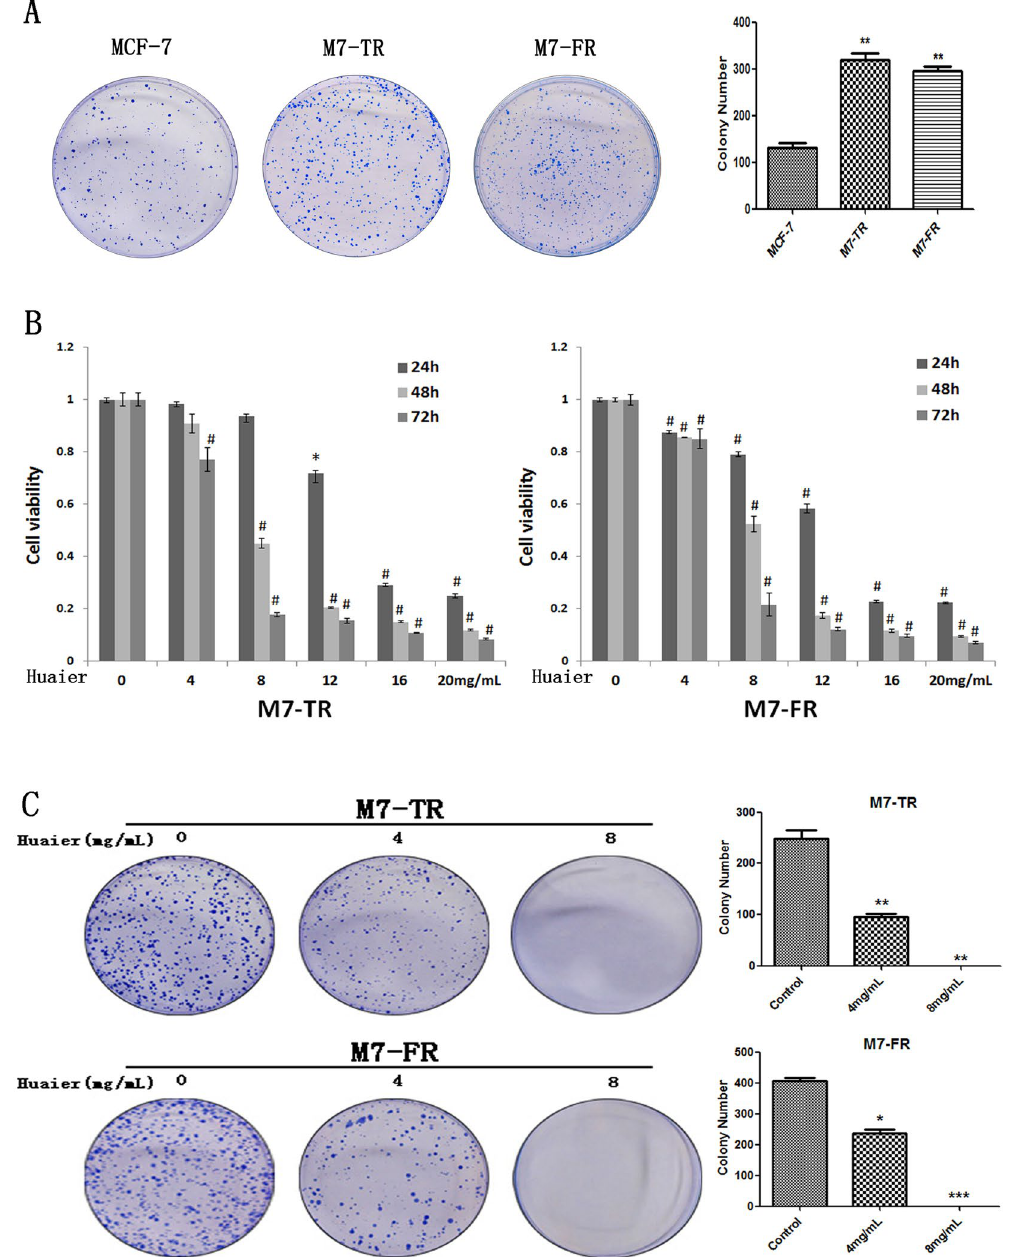
Figure 1. The effects of the indicated concentrations of Huaier extract on cell viability and clone formation capacity in M7-TR and M7-FR cells. ( A ) Cell proliferation of endocrine-resistant breast cancer cells (M7- TR and M7-FR) and endocrine-sensitive breast cancer cells (MCF-7). ( B ) The effects of Huaier extract on cell viability were measured by MTT assay. Huaier extract inhibited cell viability in both cell lines. ( C ) Representative images and the colony formation rates of M7-TR and M7-FR cell colonies after treatment with Huaier extract for 24 h. * P < 0.05 or # P < 0.01, compared with the controls. The data are presented as the mean ± SD of three separate